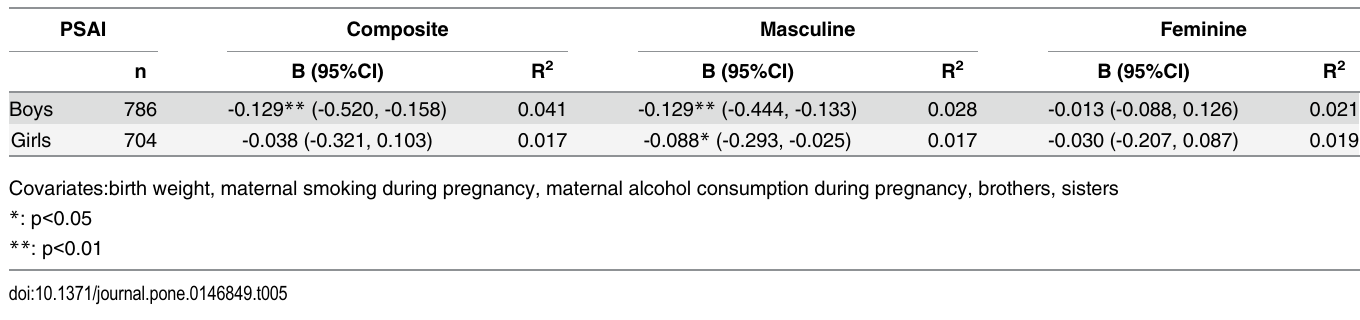
Table 5. Analyses of the relationship between 2D/4D and PSAI in a multiple linear regression analysis. PSAI Feminine